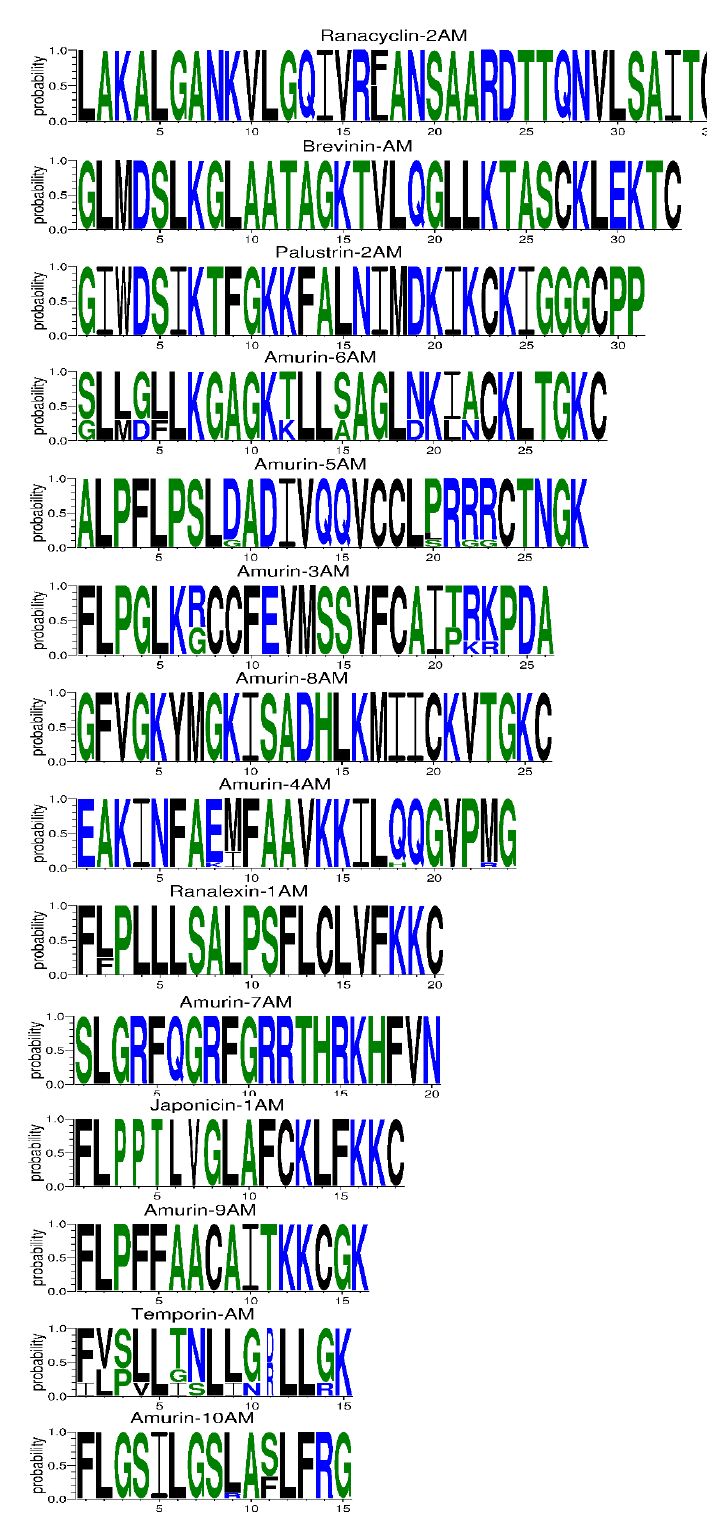
Figure 6. The primary structure of mature peptides of 14 AMP families from R. amurensis . The blue letters represent hydrophilic residues, including Arginine (R), Lysine (K), Aspartic acid (D), Glutamic acid (E), Asparagine (N), Glutamine (Q); the green letters represent neutral residues, namely Serine (S), Glycine (G), Histidine (H), Threonine (T), Alanine (A), and Proline (P); the black letters represent hydrophobic residues, including Tyrosine (Y), Valine (V), Leucine (L), Isoleucine (I), Phenylalanine (F), Tryptophane (W), Methionine (M), and Cysteine